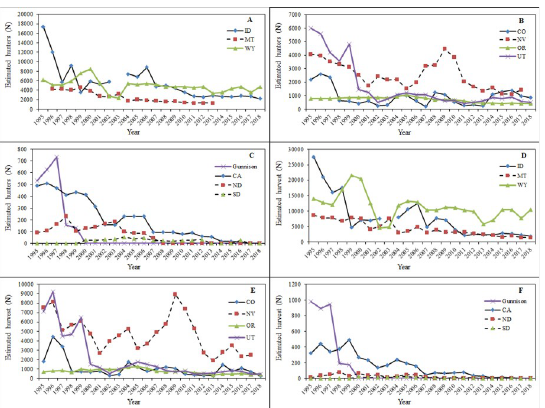
Fig 8. Estimated number of hunters (A–C) and harvest (D–F) grouped by relative abundance of greater sage- grouse among states from 1995–2018 . Data were obtained from state wildlife management